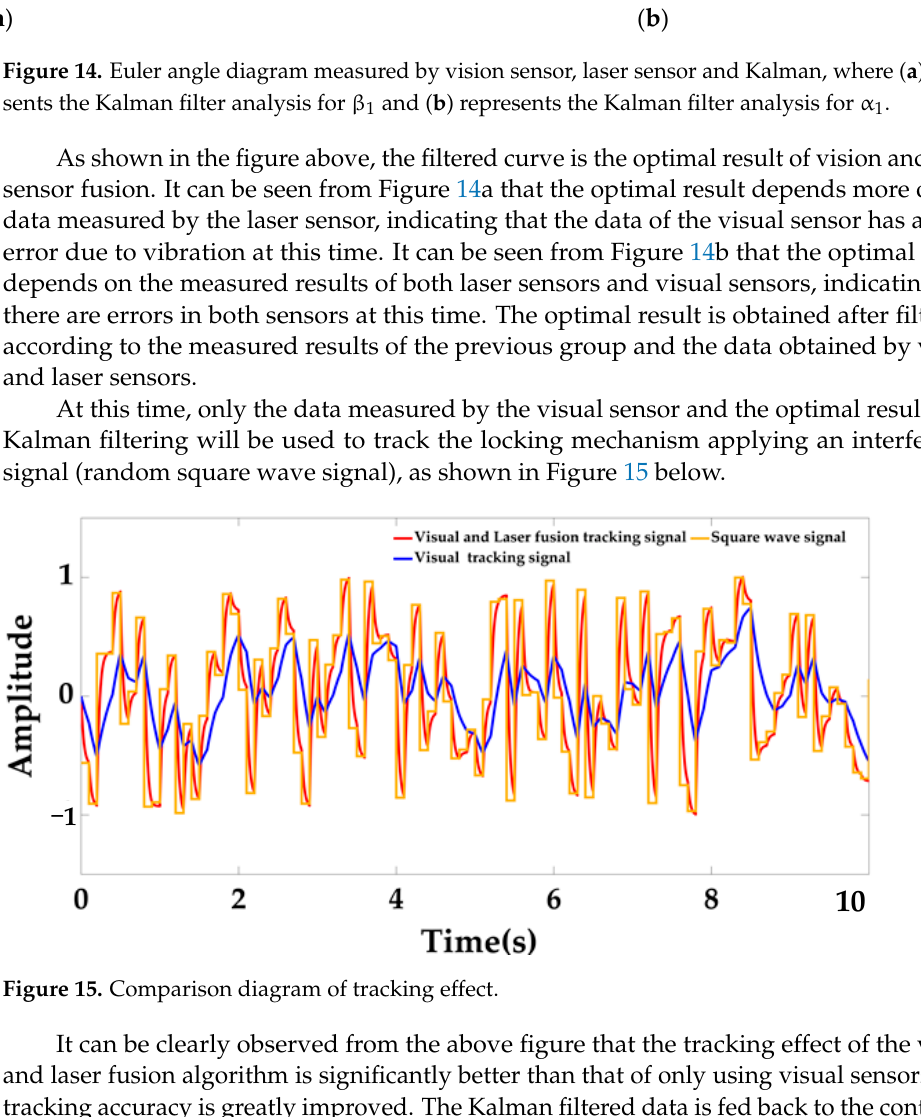
Figure 14. Euler angle diagram measured by vision sensor, laser sensor and Kalman, where ( a ) represents the Kalman filter analysis for β 1 and ( b ) represents the Kalman filter analysis for α 1 .